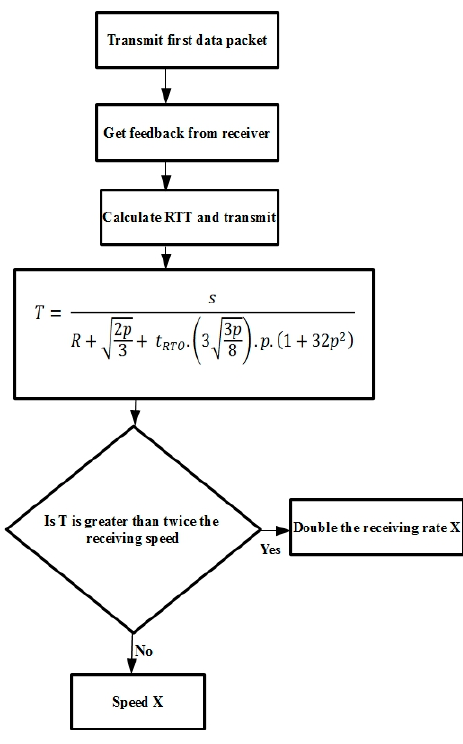
Figure 3. TFRC congestion control mechanism.